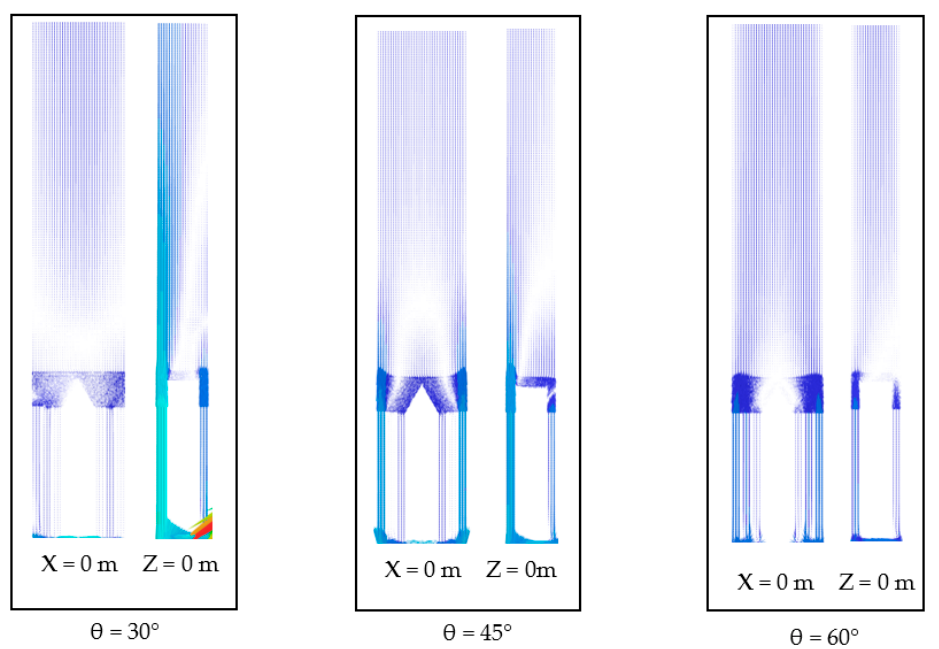
Figure 7. Streamline diagrams of different sections of the observation trough corresponding to different inlet angles.